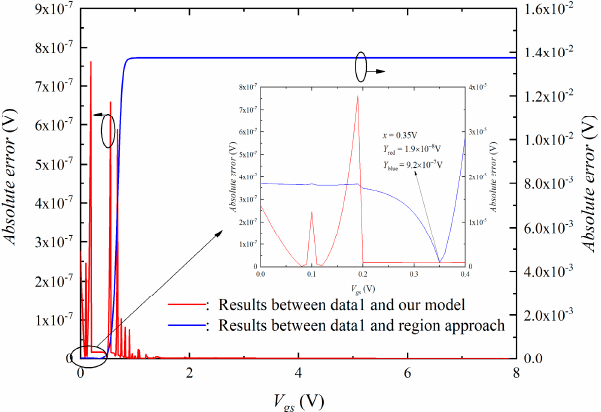
Figure 5. Absolute errors of surface potential results between our model, regional approach and numerical results using data1.